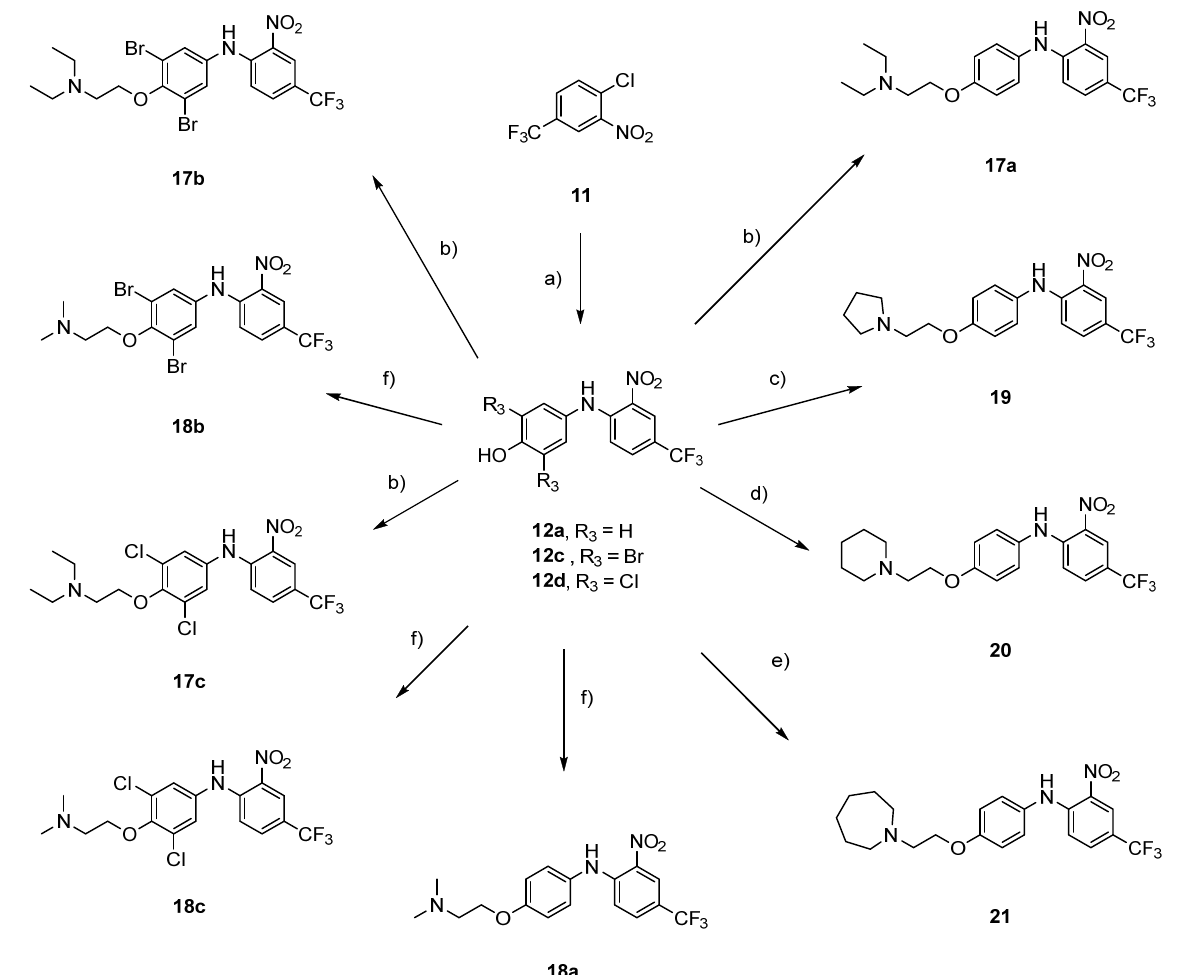
Scheme 5. Reagents, solvents, and conditions: ( a ) 4 ‐ aminophenol or 4 ‐ amino ‐ 2,6 ‐ dibromophenol